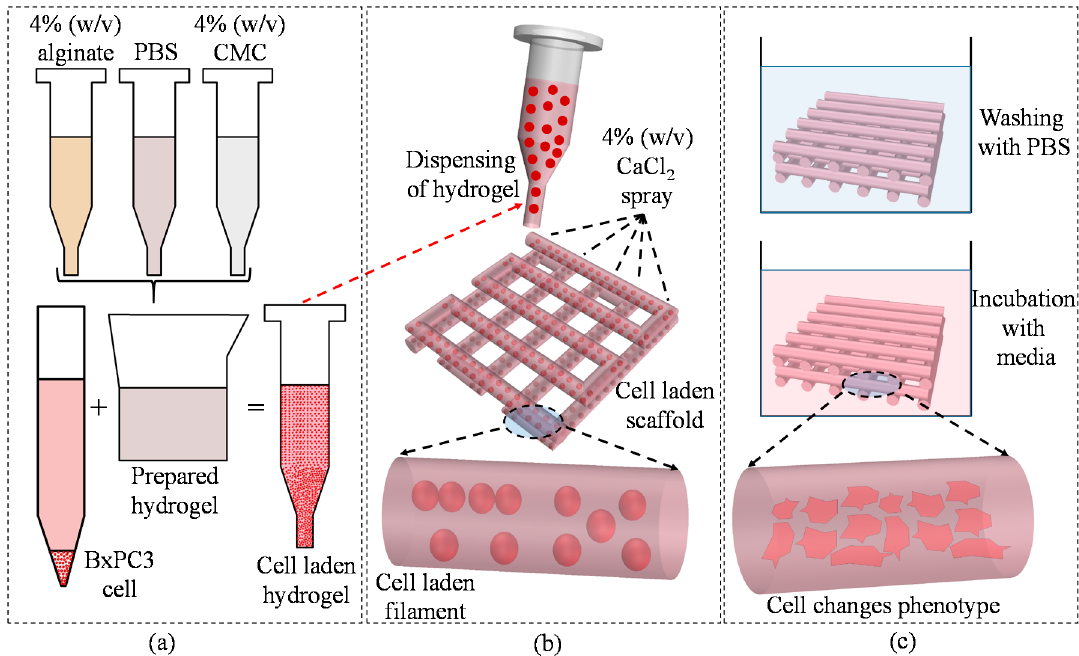
Figure 7. ( a ) Preparation of cell-laden hydrogel; ( b ) bio-printing of the cell-laden hydrogel; and ( c ) incubation of fabricated scaffold. Rheology.